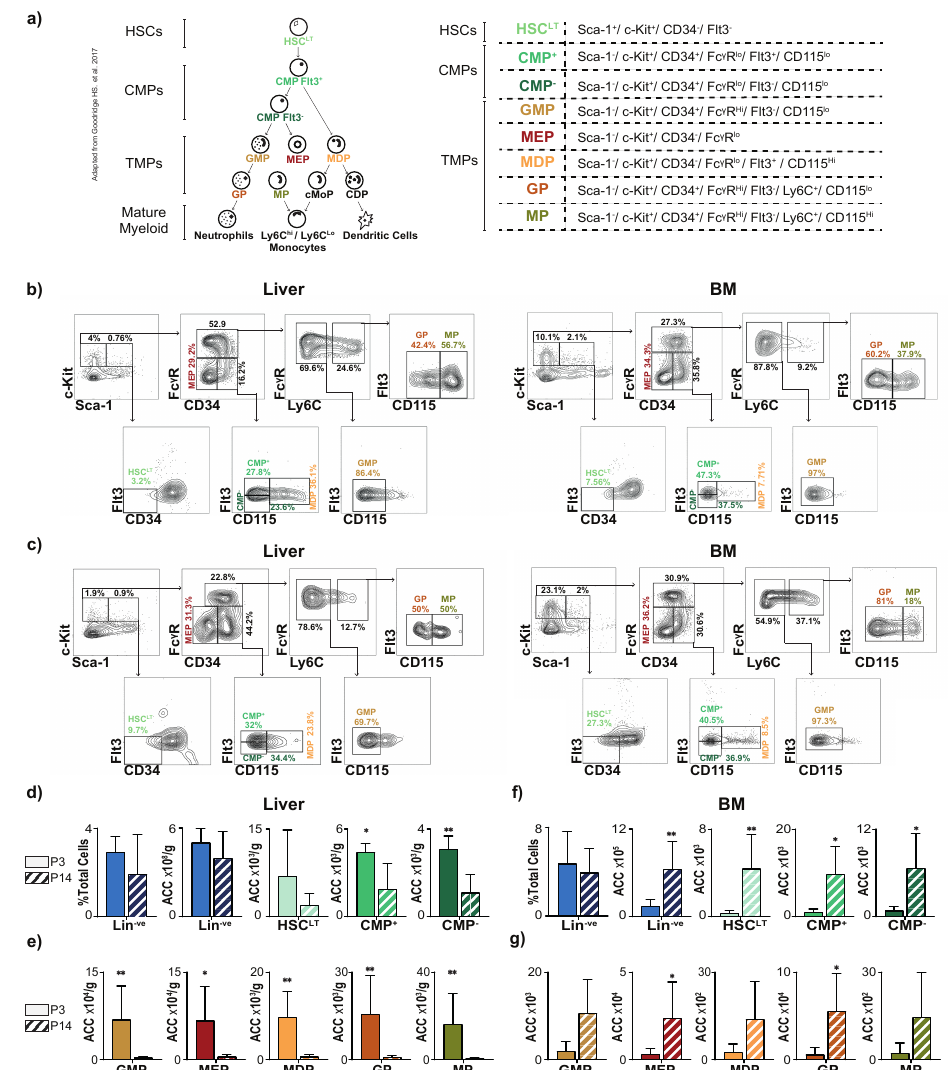
Figure 1. The liver is the main reservoir for myeloid progenitors in neonatal mice. ( a ) Schematic showing differentiation hierarchy and cell-surface markers of hematopoietic stem and progenitor cells (HSPCs): long-term hematopoietic stem cells (HSC LT ), common myeloid progenitors (CMP + and CMP - ), and terminal myeloid progenitors (TMP: megakaryocytic-erythroid progenitors, MEP; monocytic-dendritic progenitors, MDP; granulocytic-monocytic progenitors, GMP; granulocytic progenitors, GP; monocytic and common monocytic progeni- tors, MP), and mature myeloid populations. Plots demonstrating flow cytometric gating strategy of HSC LT s, CMPs, and TMPs in liver and bone marrow (BM) of PBS- injected mice on postnatal day 3 (P3) in (b) and postnatal day 14 (P14) in (c) . Quantification of lineage negative (Lin -ve ) fraction and absolute cell counts (ACC) of Lin -ve , HSC LT , and CMP populations on P3 and P14 of life in (d) liver and (f) BM. Quantification of TMPs in P3 and P14 (e) liver and (g) BM. n=6 for each group. p-value *<0.05; **<0.01. Error bars represent mean ± SD.